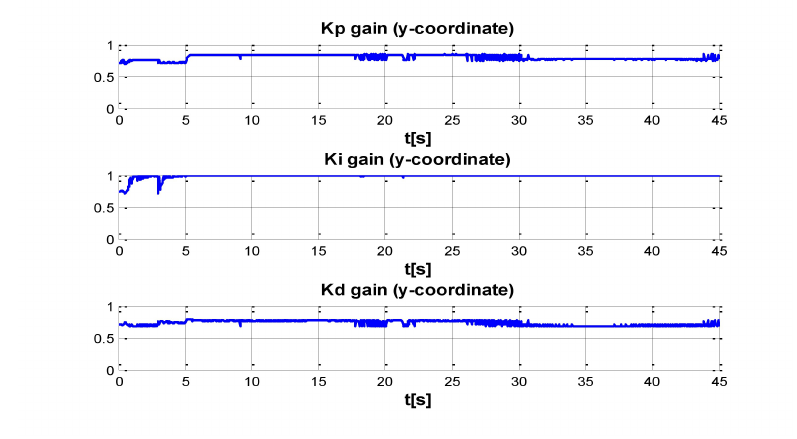
Figure 10. PID gain time behavior in y-coordinate.